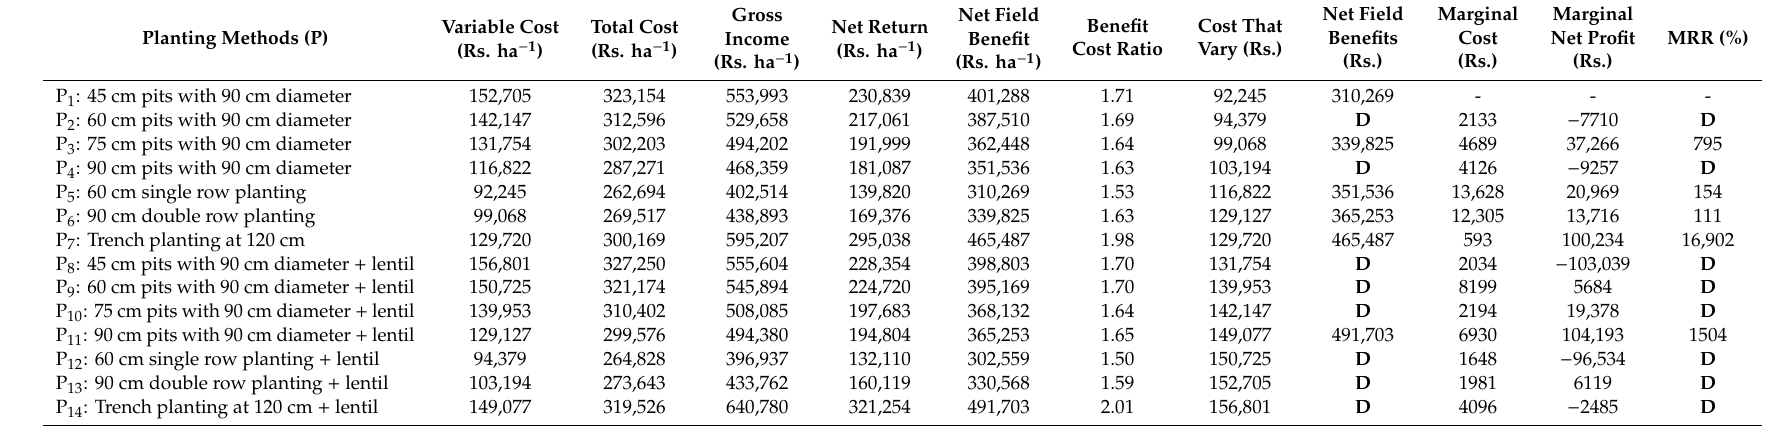
Table 5. E ff ect of di ff erent sugarcane-lentil based intercropping systems on average net return, average net field benefits, and average benefit-cost ratio 2013–2016 (each value is the average total experimental duration). MRR: marginal rate of